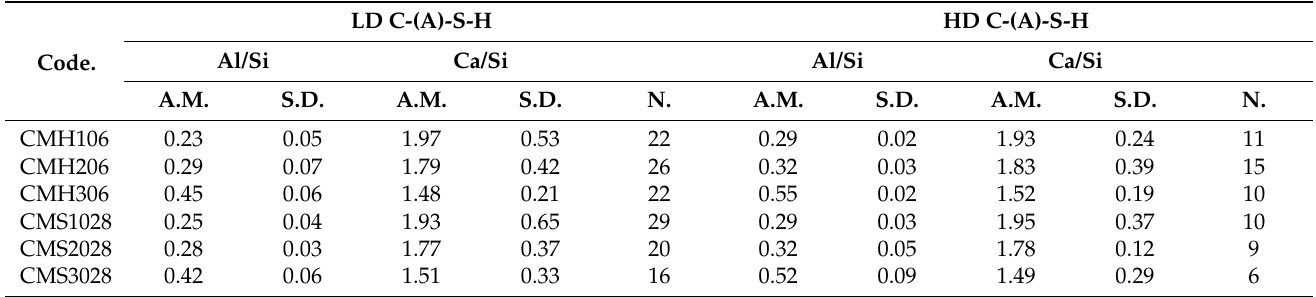
Table 3. Mean Ca/Si and Al/Si atom ratios obtained for C-(A)-S-H using SEM-EDX (A.M. = arith- metical mean; S.D. = standard deviation; N. = number of